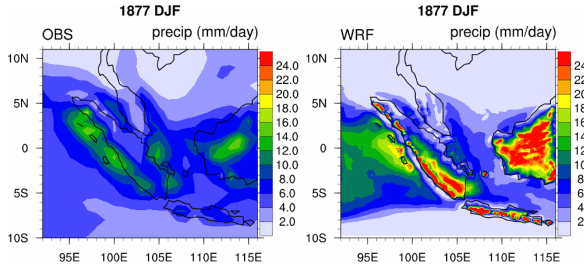
Figure 5. Weather Research and Forecasting (WRF) and OBS sim- ulations of DJF 1877 using observational data from seven stations in Singapore using NCEP reanalyses. Source: Tropical Marine Sci-